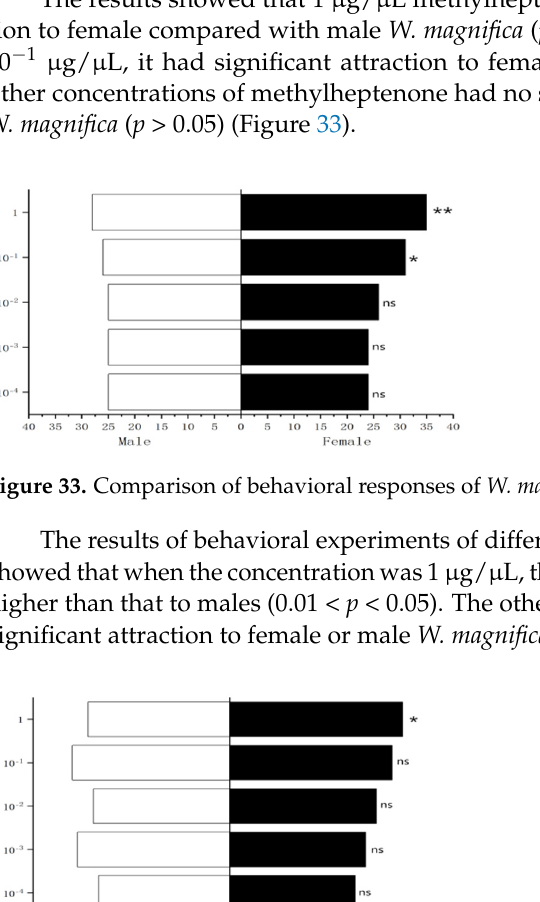
Figure 32. Behavioral responses to propyl butyrate in female W. magnifica .